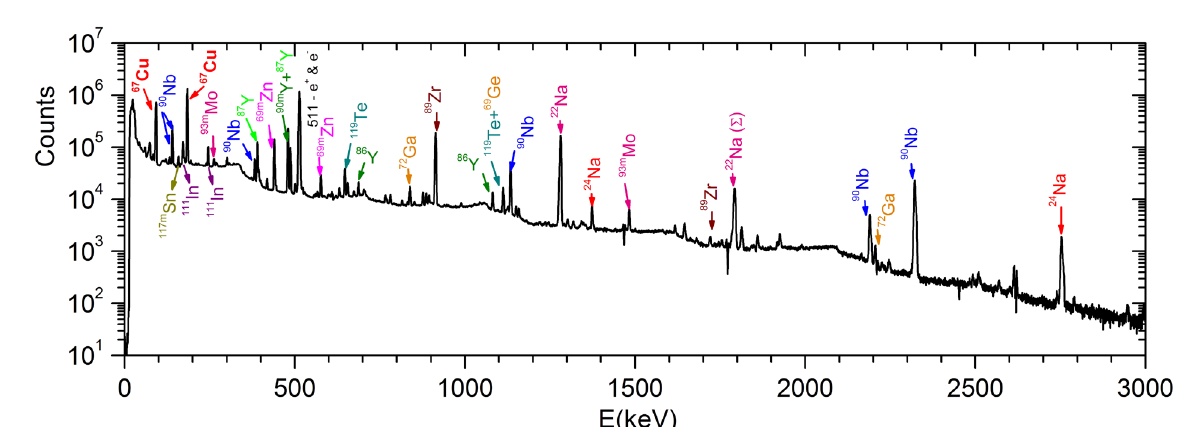
Fig. 2. Al catcher foil background-subtracted γ -ray spectrum after the interaction of a 70 Zn (15 MeV/nucleon) beam with the hydrogen gas cell after 36.5 h from the end of the irradiation. The peaks are labelled with the corresponding radionuclides. The peak marked 22 Na is the sum peak induced by the simultaneous detection of the β delayed γ− ray (1275 keV) and 511 keV γ -ray from e + & e - ( Σ )